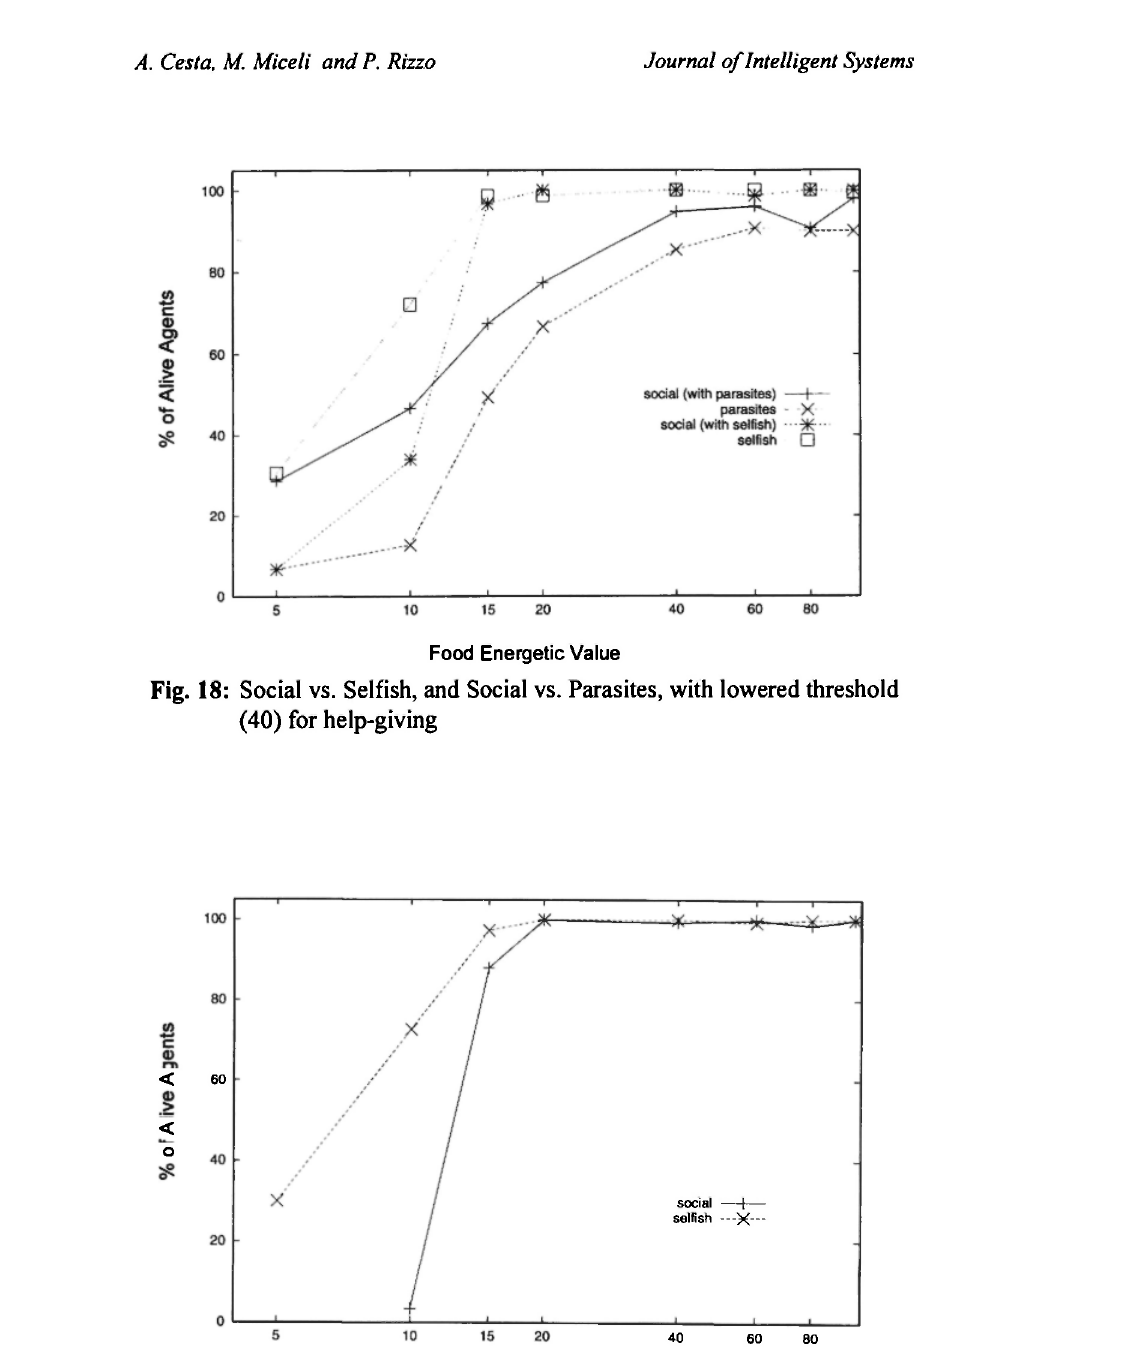
Fig. 19: Social vs. Selfish with lowered threshold (20) for